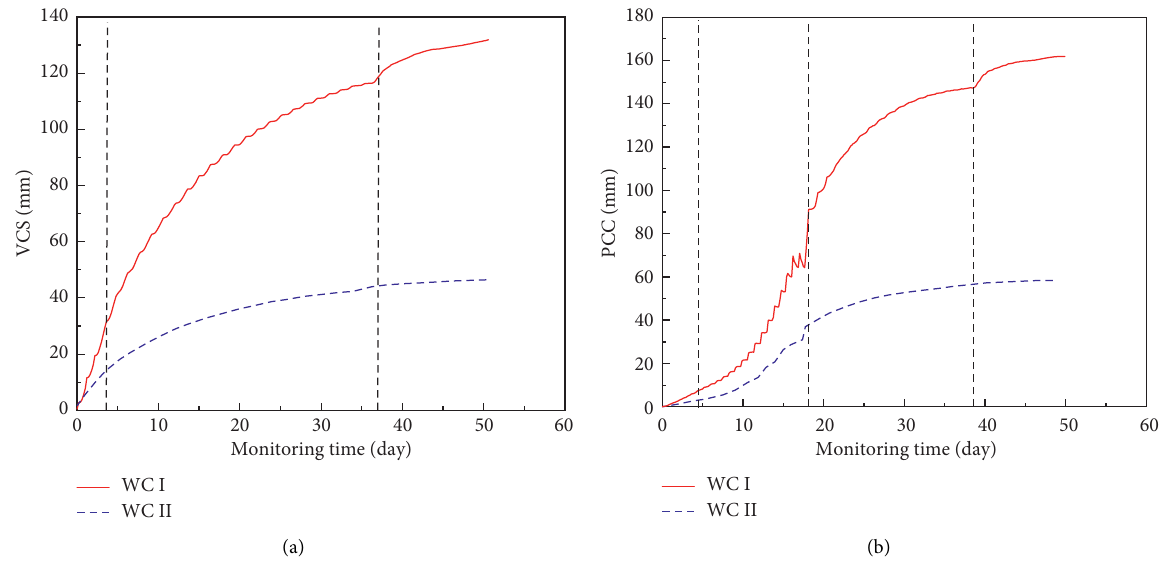
Figure 12: Comparison of single-layer steel arch support and double-layer steel arch support. (a) The VCS of WC I and WC II. (b) The PCC of WC I and WC